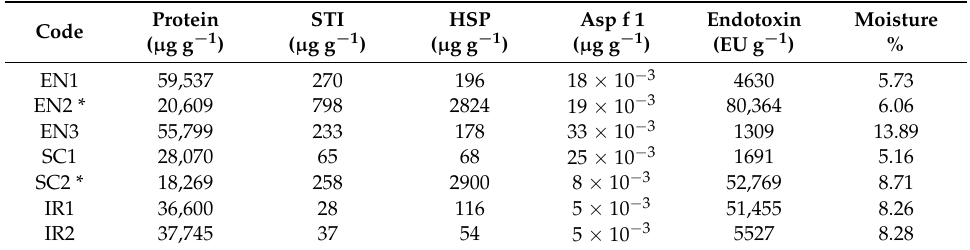
Table 1. Mean concentrations of protein, allergens, and endotoxin readily extractable from duplicate bulk samples.